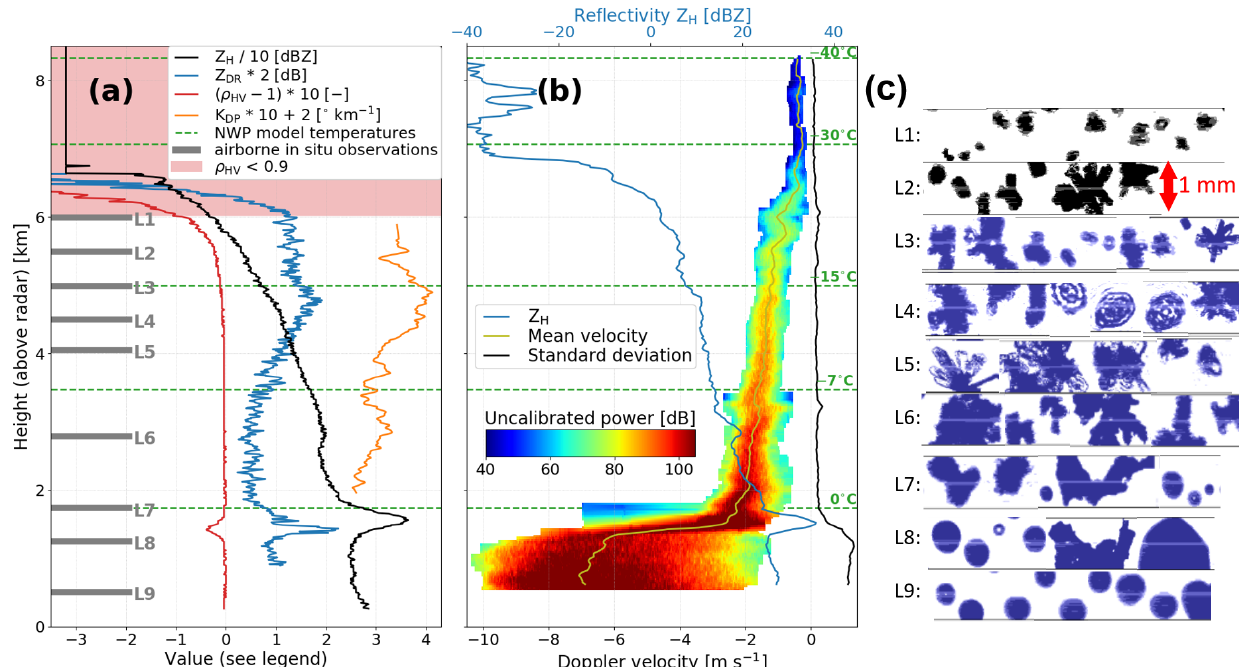
Figure 3. Measurements of slant-viewing and zenith-pointing polarimetric C-band weather radar scans with NWP model-based temperature levels and airborne in situ observations: (a) quasi-vertical profiles (QVPs) of radar reflectivity Z H , differential reflectivity Z DR , copolar cross- channel correlation coefficient ρ HV , and the specific differential phase K DP estimated from (noisy) measurements of the differential phase by aggressive filtering above the melting layer. (b) Average Doppler spectra from a 15s birdbath scan and corresponding first three moments at each radar bin height: reflectivity, power-weighted mean velocity, and standard deviation. (c) In situ particle images (downward-looking projection images) collected at altitudes L1 to